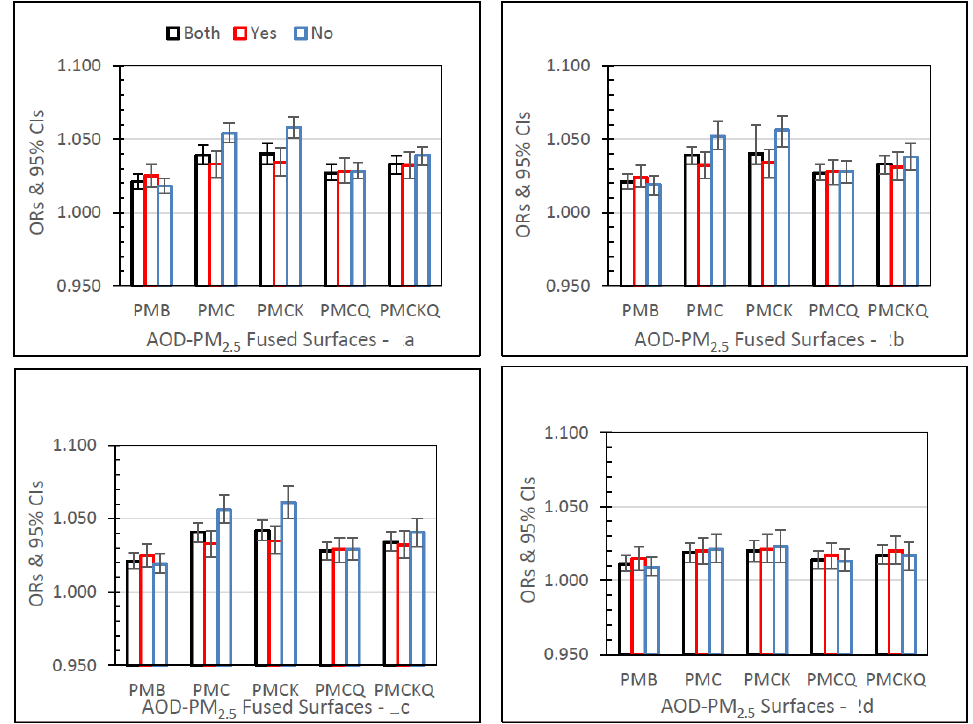
Figure 2. ED asthma ORs (95% CIs) for the four AOD-PM 2.5 and baseline PMB fused surfaces, in all grids (Both), and in grids with (Yes) and without (No) air monitors, and in separate panels for lag grids 0 ( a ), 1 ( b ), 01 ( c ), and 04 ( d ).